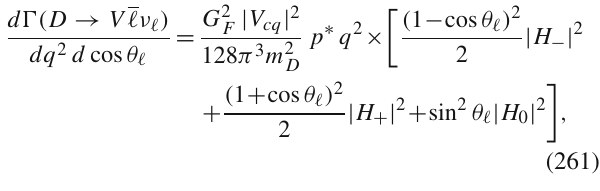
+ 4 sin θ (cid:12) ( 1 − cos θ (cid:12)